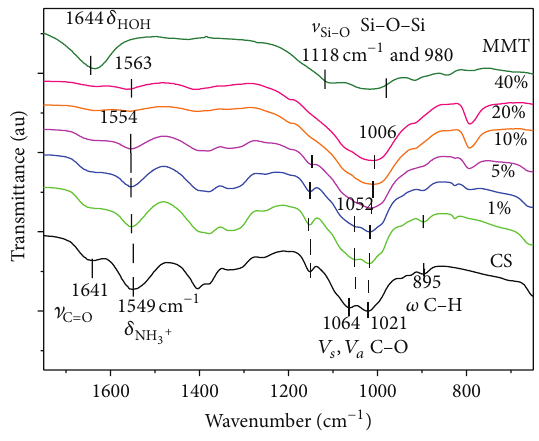
Figure 2: FTIR spectra of chitosan clay nanocomposites films obtained at different wt%